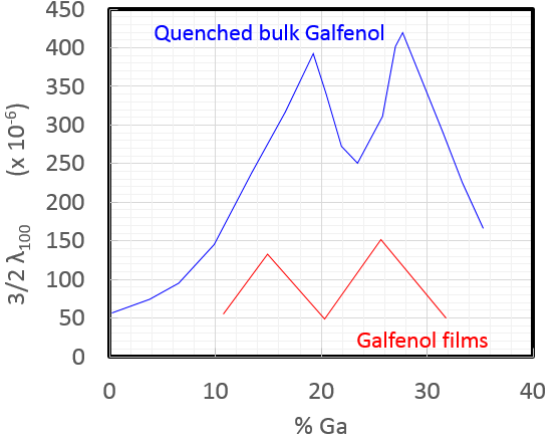
Figure 1. Magnetostriction vs. composition trends in bulk (blue, [7]) and sputtered films (red, [8]).